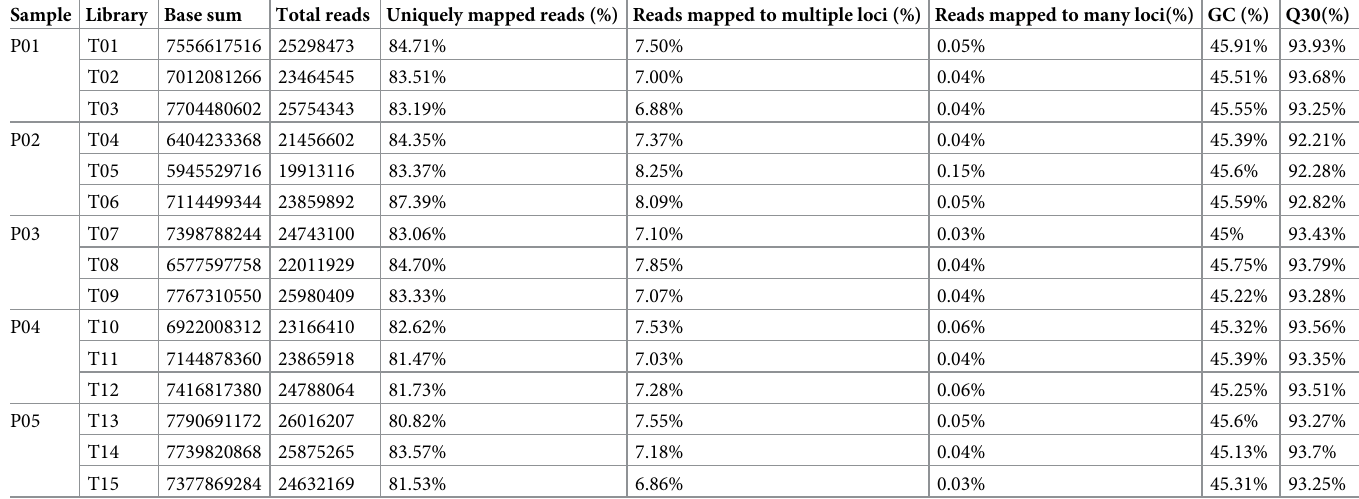
Table 1. Summary of transcripts detected from RNA sequencing data. Sample Library Base